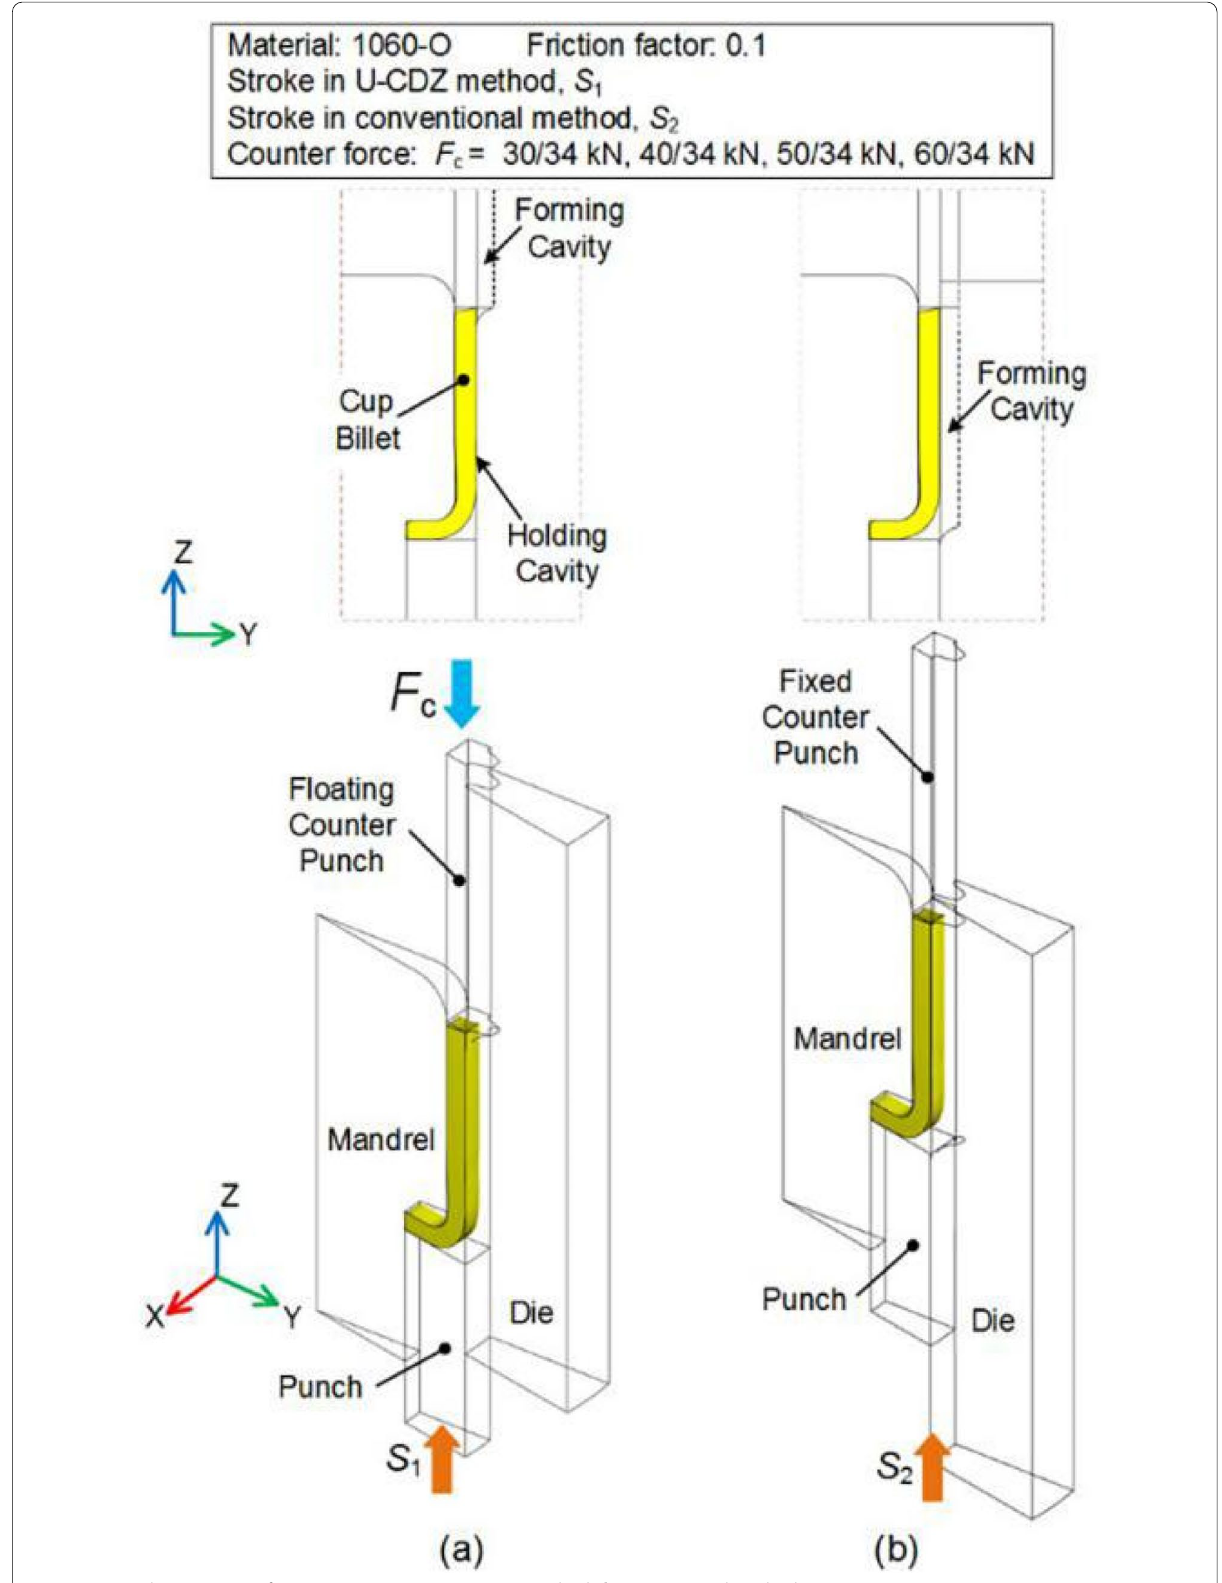
Figure 8 Simulation settings for upsetting process: ( a ) U-CDZ method, ( b ) conventional